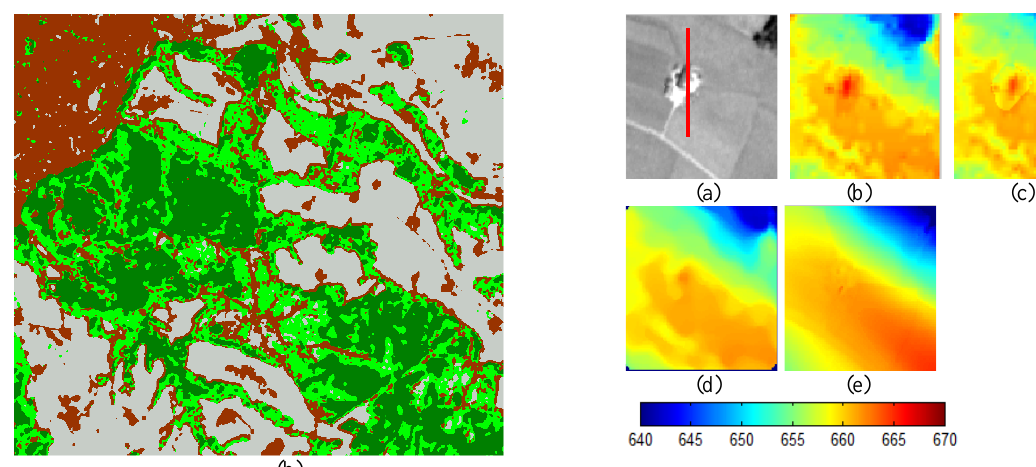
Figure 6. DTM generation procedure of building example (a) panchromatic images ; (b) original DSM; (c) DTM1; (d) refined DTM; (e) reference DTM.